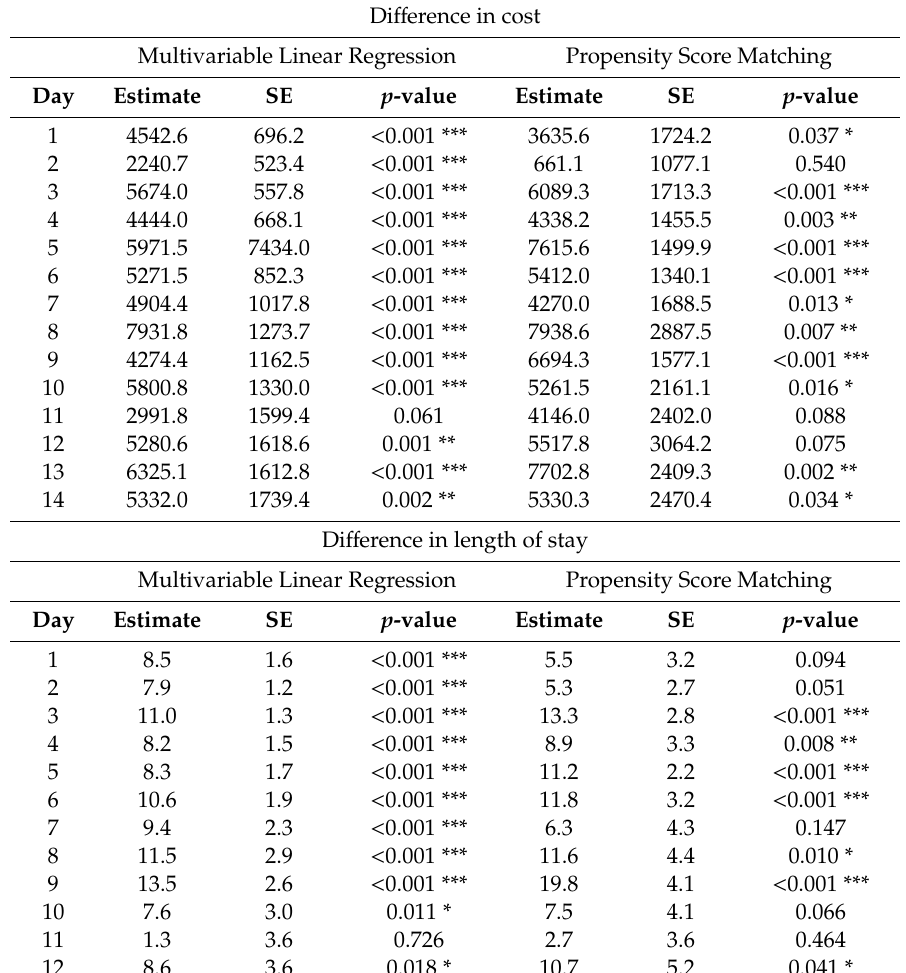
Table 5. Di ff erences in cost and length of stay for tube and line events (reference: without event).